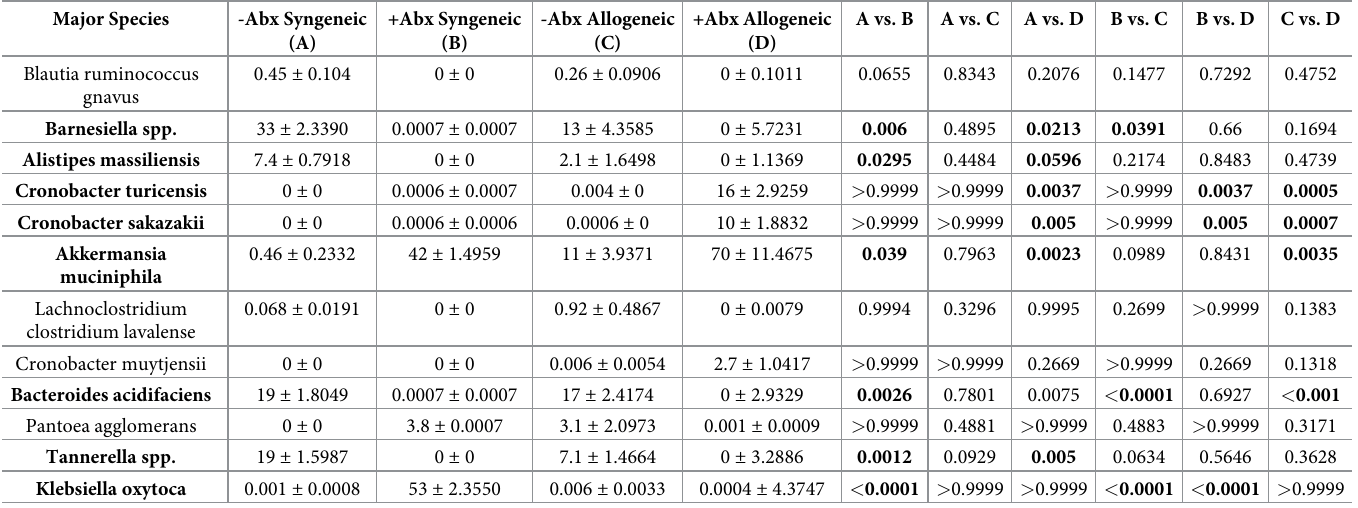
Relative abundance of the major species was determined using 16S rDNA amplicon sequencing of fecal DNA in the 4 groups described in Fig 1. The mean ± SEM values (% relative abundance) for each group are reported. p values are reported for each group